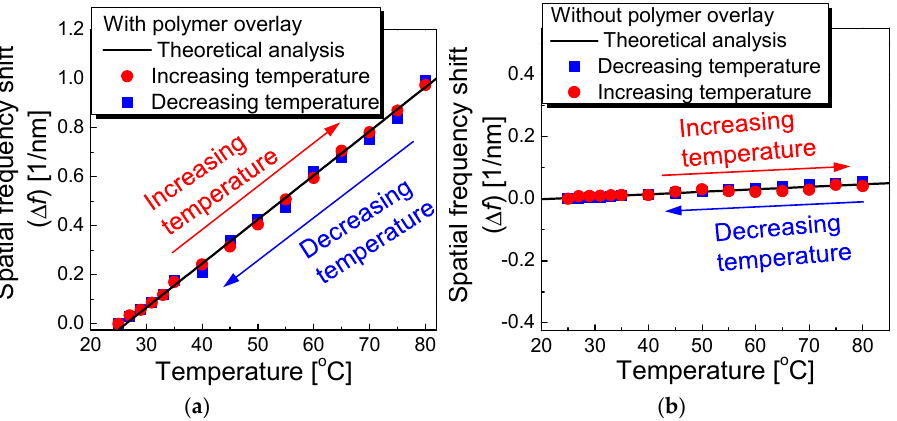
Figure 6. Spatial frequency shift ( Δ f ) ( a ) with and ( b ) without a polymer overlay as a function of temperature.